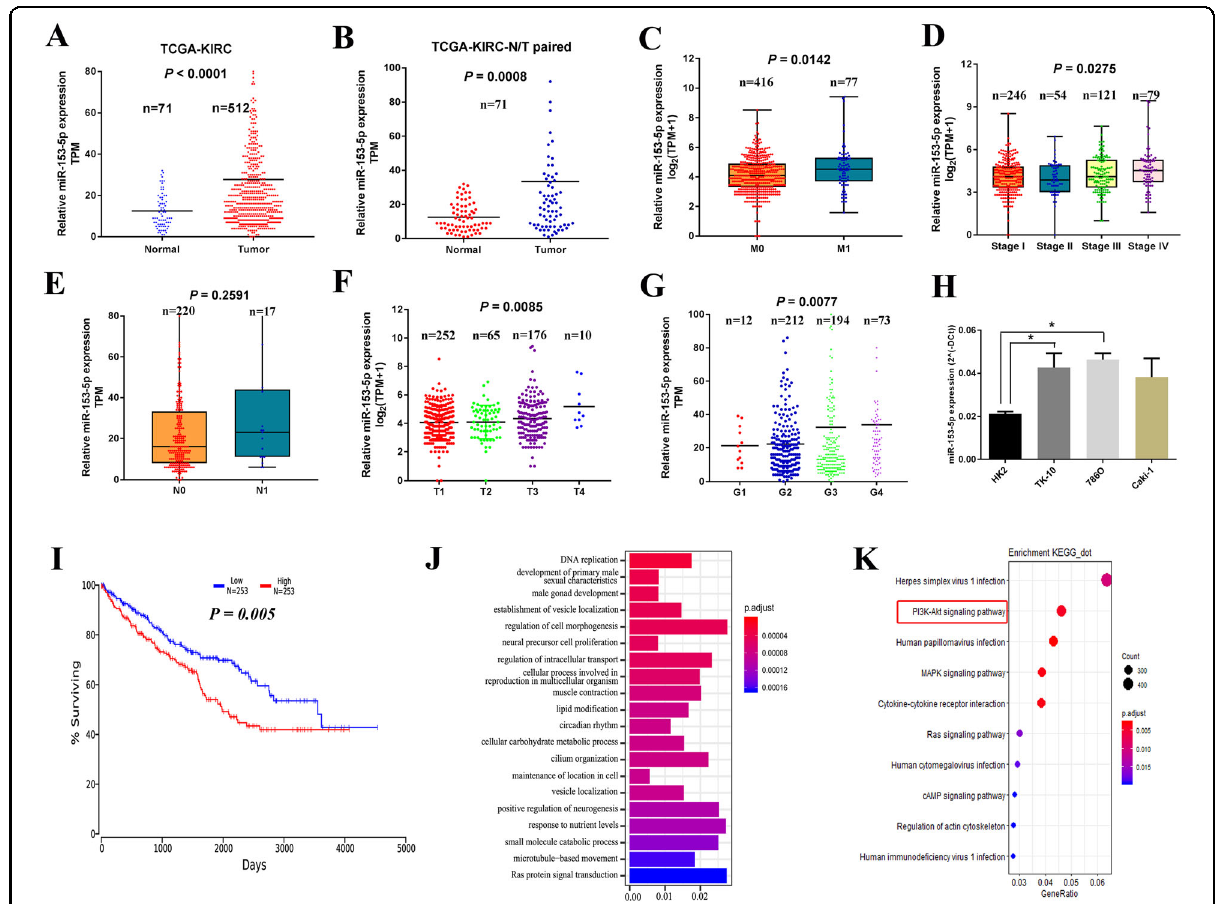
Fig. 2 MiR-153-5p is aberrantly overexpressed in ccRCC and related to unfavorable clinical features and prognosis. A , B Relative expression of miR-153-5p in tumor-normal tissues ( A ) and paired tumor-normal tissues ( B ) of TCGA. Horizontal lines represent the mean value. C – G Correlation of miR-153-5p with clinicopathological characteristics, including metastasis ( C ), TNM stage ( D ), lymph node metastasis ( E ), T stage ( F ), and histologic grade ( G ). H The expression level of miR-153-5p in ccRCC cell lines and human renal tubular epithelial cells. Horizontal lines in F , G represent the mean value. Horizontal lines in the boxes in C – E indicated the median value. Boxes span the interquartile range. Whiskers extend from the minimum to the maximum. The values in H are presented as mean ± SEM. I Kaplan – Meier analysis of the correlation between miR-153-5p and overall survival in ccRCC. J , K Gene Ontology (GO) enrichment analysis ( J ) and Kyoto Encyclopedia of Genes Genomes (KEGG) pathways enrichment analysis ( K ) for the expression of miR-153-5p. All experiments were conducted at least three independent times. * P <